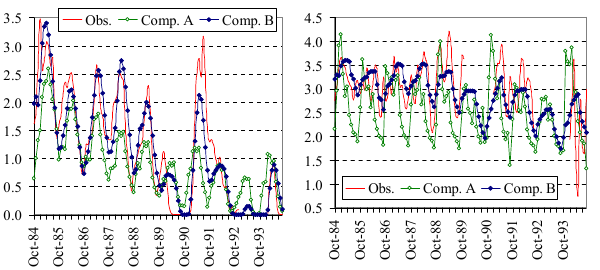
Fig. 7. Simulated discharge (m 3 s − 1 ) at Mavroneri springs (mean 3 s − 1 ) at Mavroneri Figure 7 Figure 6 Fig. 6. Computed and observed discharge (m and 50% prediction limits) under the actual abstraction policy (left) (left) and Melas (right) springs, for modelling frameworks A and B. and the intensive abstraction policy (right) for the water supply of Athens, according to modelling framework A.